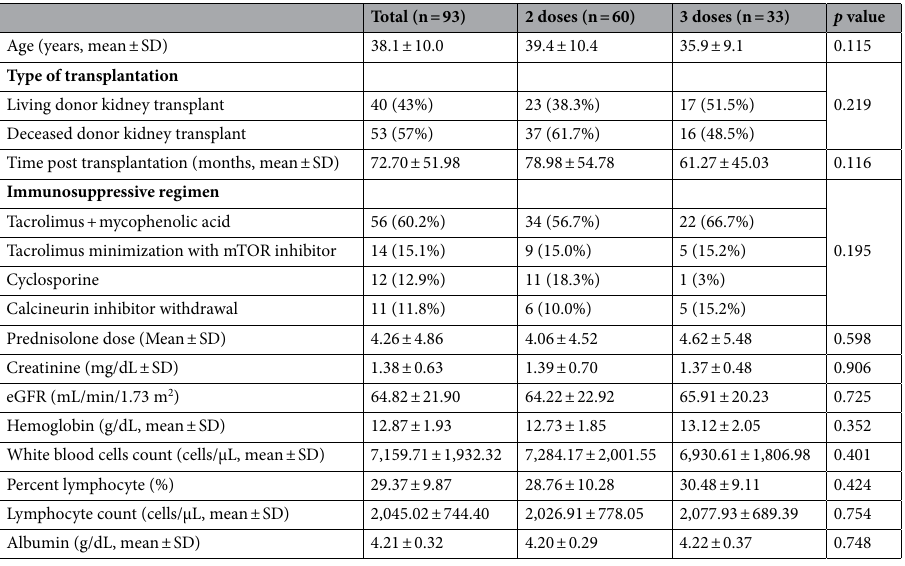
Table 2. Baseline characteristics of the participants who received 2- and 3-dose regimens of hepatitis A vaccine. eGFR; estimated glomerular filtration rate by CKD-EPI.